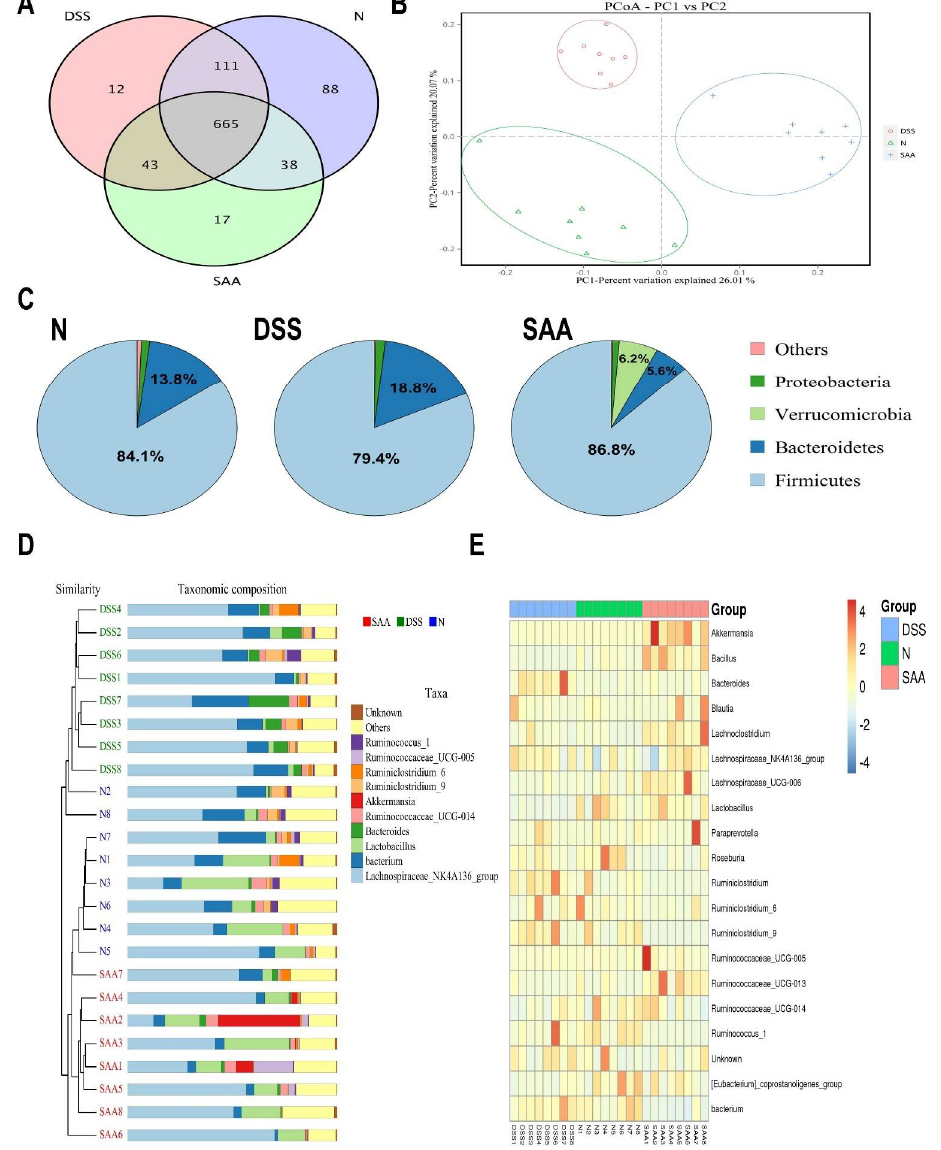
Figure 5. Effects of SAA on gut microbial composition in DSS-induced-colitis rats in a single experiment. ( A ) Venn diagram showing overlapping operational taxonomic units (OTUs) identified in the intestinal microbiota in the normal control, DSS, and SAA groups. ( B ) Principal coordinates analysis (PCoA) plot of the gut microbiota based on weighted UniFrac metrics. ( C ) Structural comparison of intestinal microbiota between the three groups at the phyla level. ( D ) Hcluster analysis of the gene levels for the three experimental groups. ( E ) Heat map of the 20 most differentially abundant taxons in the three groups at the gene level.